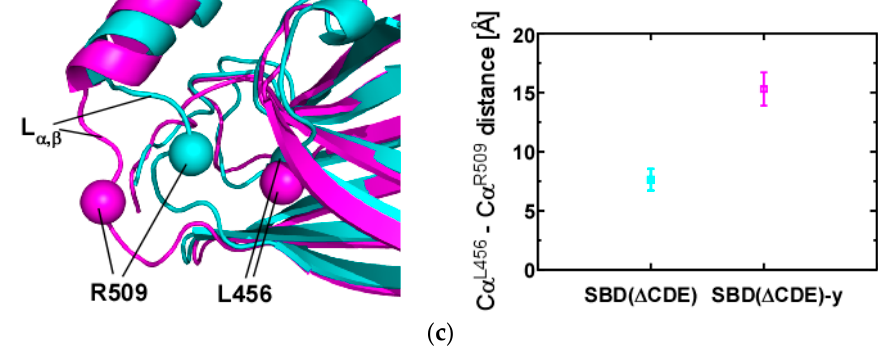
Figure 4. Structural comparison between SBD( ∆ CDE) and SBD( ∆ CDE)-y of human Hsp70. ( a ) Superposition of the lowest-energy NMR structures of SBD( ∆ CDE) (cyan) and SBD( ∆ CDE)-y (magenta). The L α , β loop in both structures is marked in red; ( b ) Comparison of the substrate binding loops L 1,2 and L 3,4 . C α atoms in residues at the tip of the loops are show as spheres: A406 (L 1,2 ) and Y431 (L 3,4 ) ( left ). The average and standard deviation of the A406–Y431 C α distance for the 10 lowest-energy structures of SBD( ∆ CDE) (cyan) and SBD( ∆ CDE)-y (magenta) are presented ( right ); ( c ) Structural comparison of the L α , β loop between SBD( ∆ CDE) (cyan) and SBD( ∆ CDE)-y (magenta). C α atoms of the residue located in the middle of the L α , β loop (R509) and L456 in β 5 are shown as spheres ( left ). The average and standard deviation of the L456-R509 C α distance for the 10 lowest-energy structures of SBD( ∆ CDE) (cyan) and SBD( ∆ CDE)-y (magenta) are presented ( right ).